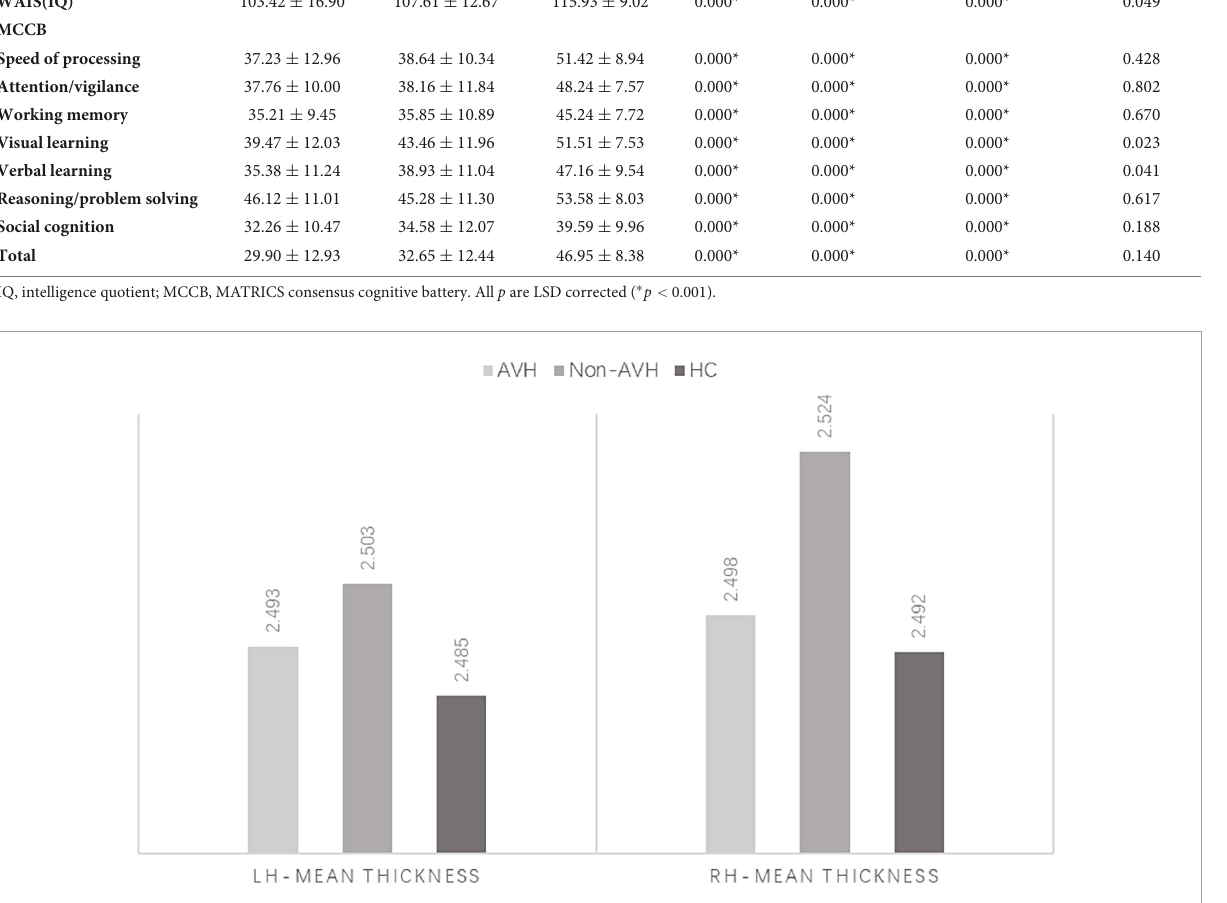
FIGURE1 Mean cortical thickness of the left and right hemisphere. lh, left hemisphere; rh, right